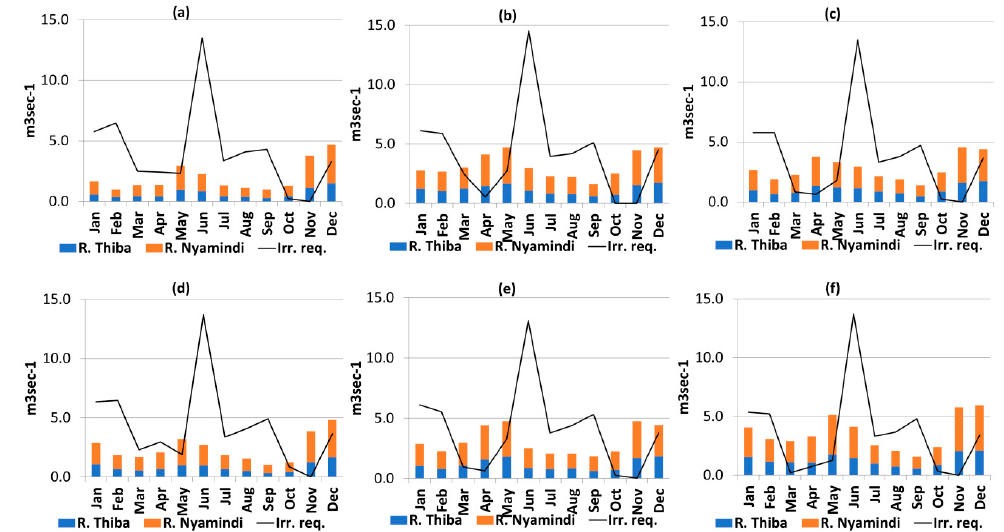
Figure 10. RCP 6.0 Comparison of total available flow and irrigation water requirements during